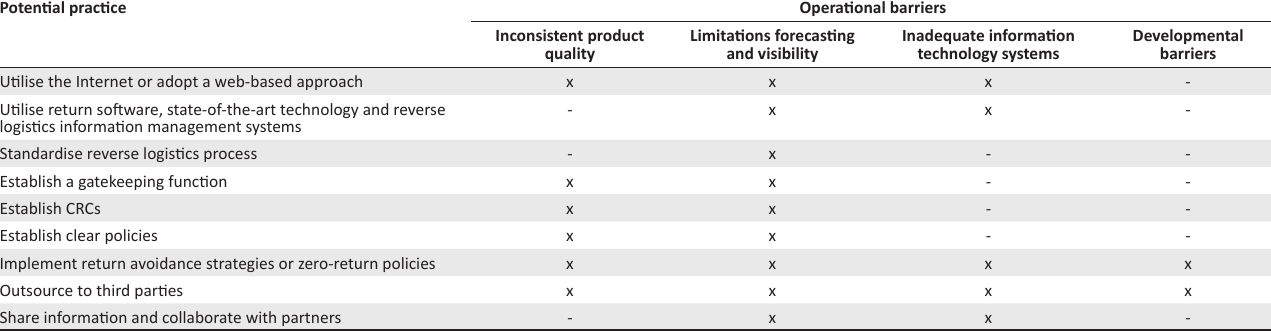
TABLE 1: Theoretical framework of practices to overcome operational barriers in reverse